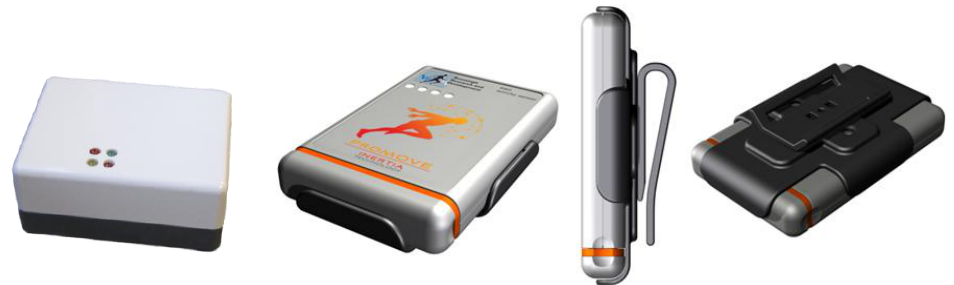
Figure 1. Images of the ProMove2 ( left ) and ProMove3D ( right